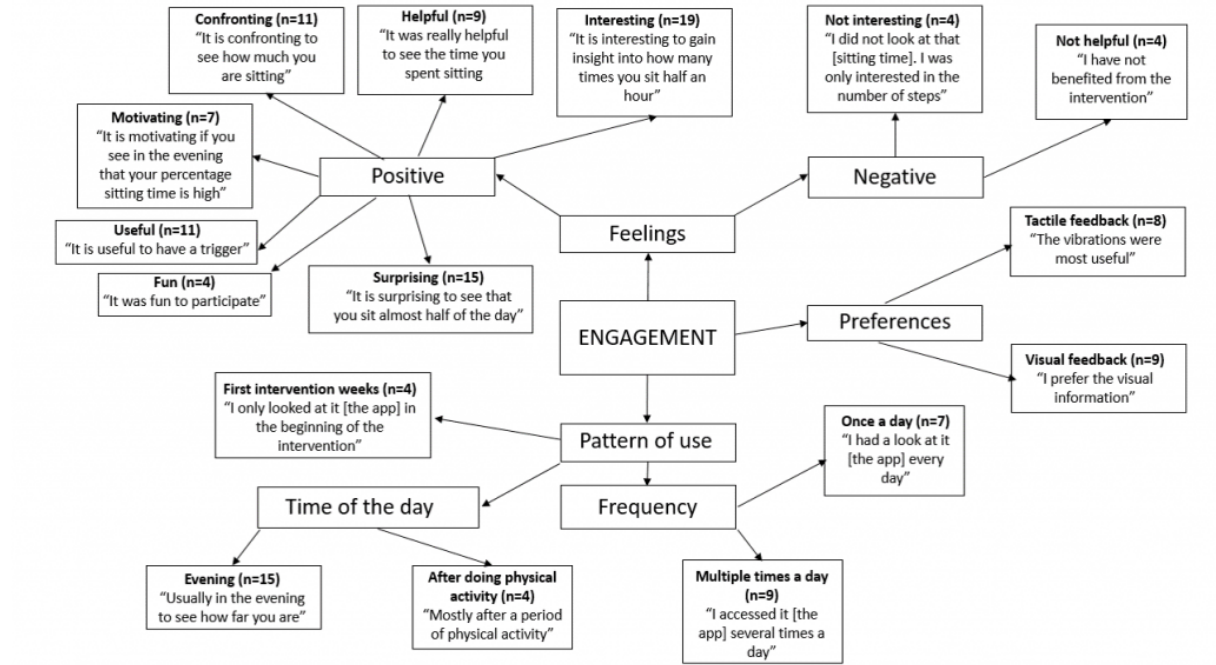
Figure 3. Pen profile of engagement with the